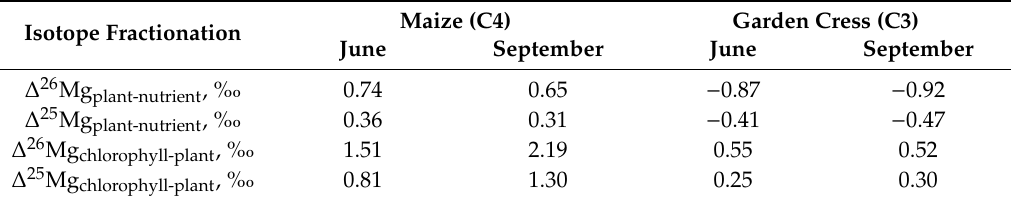
Table 3. Mg-isotope fractionation observed during 11-day plants growth and chlorophyll-a biosynthesis. Maize Isotope Fractionation